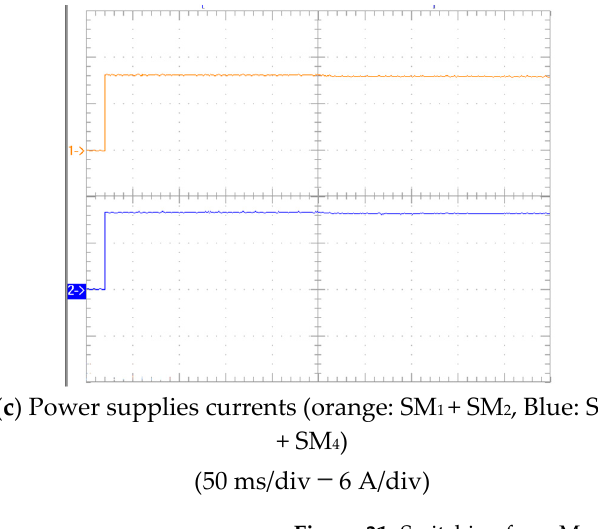
Figure 31. Switching from Mode 2.2 to Mode